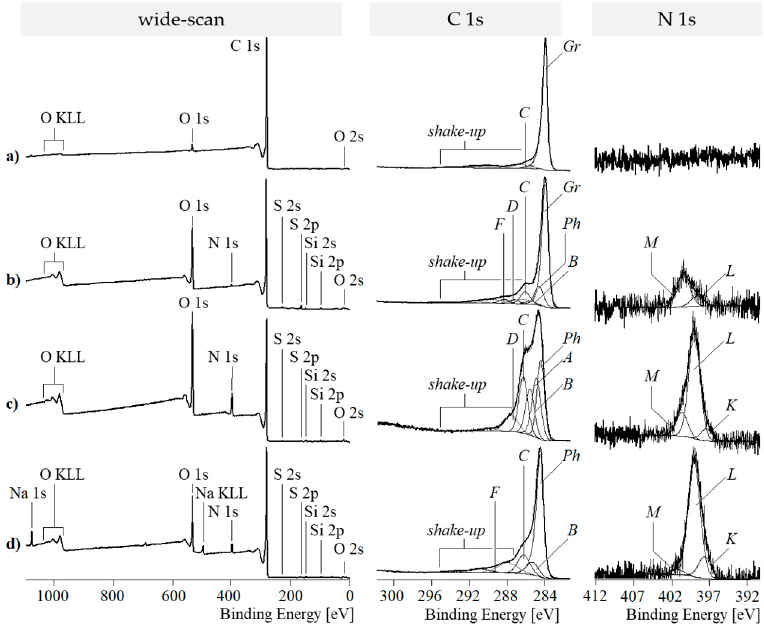
Figure 4. Wide-scan (left column), high-resolution C 1s (middle column) and N 1s (right column) XPS spectra recorded from: ( a ) graphene stacks; ( b ) GO; ( c ) PDA-GO_30; and ( d ) RGO_30.